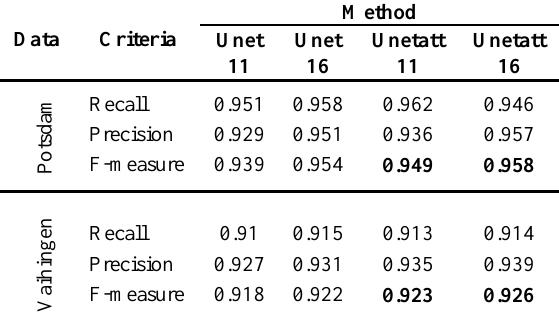
Table 1. Accuracy measures of the three algorithms for the building extraction results using Recall, Precision, and F- measure in test images of two